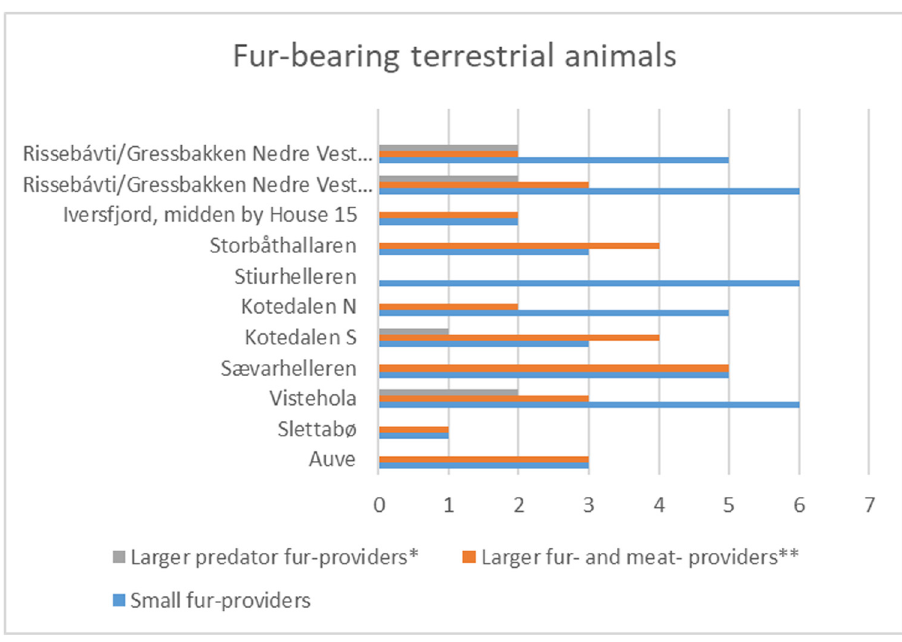
Figure 3: Diagram showing variations in number of terrestrial fur - bearing mammals at the case study sites, arranged north ( top ) – south ( bottom ) . Animal species are sorted according to size and combined value as fur/hide - and meat - provider. Larger predators: wolf, wolverine, lynx, and badger ( n = 4 ) ; Larger fur - and meat - providers: reindeer, red deer, roe deer, elk, brown bear, beaver, and wild boar ( n = 7 ) ; Small fur - providers: otter, hare, red fox, Arctic fox, weasel, squirrel, polecat, and marten ( n = 8 )